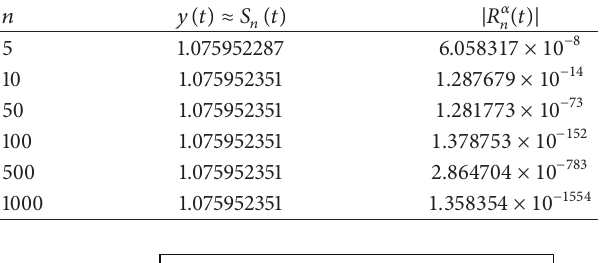
Table 3: 𝐹(𝑘) and 𝑌(𝑘) values in Example 2 for 𝛼 = 0.9 , 𝑡 = 0.05 , and 𝑘 ≤ 10 .